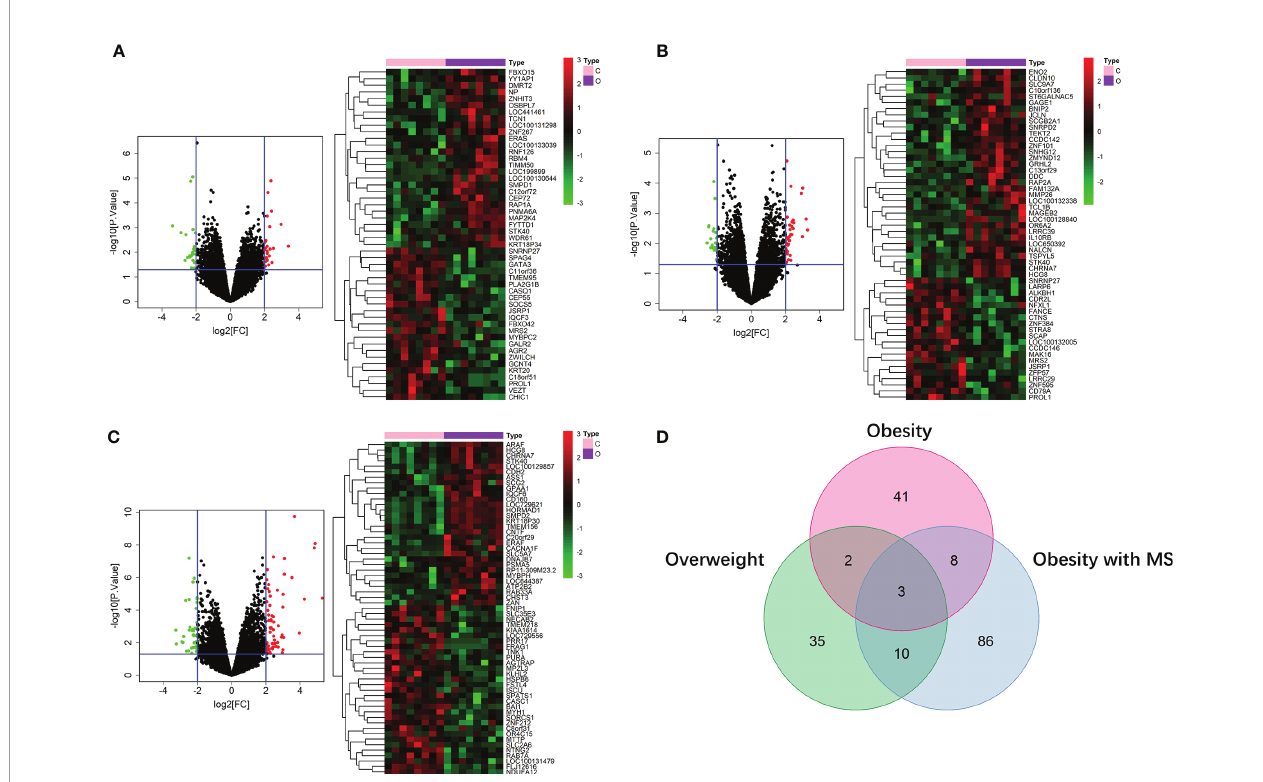
FIGURE 3 | DE mRNAs of overweight (A) , obesity (B) , and obesity with MS (C) in SAT. The red points in the volcano plots represent upregulation and the green plots represent downregulation. The color in heatmaps from green to red shows the progression from low expression to high expression. The amount of DE mRNAs of obesity in VAT was 185 (50 for overweight, 54 for obesity, and 107 for obesity with MS). Venn diagram (D) shows that only 3 mRNAs (JSRP1, MRS2 and STK40) were shared by all these 3 obesity